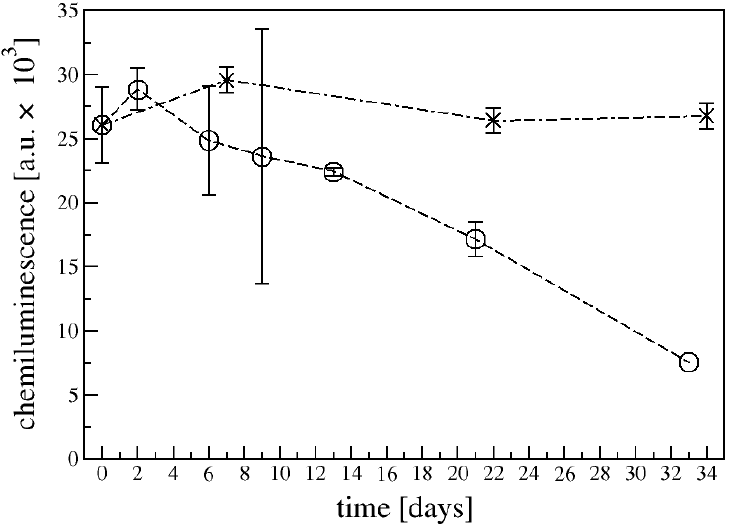
Figure 5. Apt-THR layer aged in PBS solution at 4 ◦ C (circles) [4] or − 20 ◦ C (stars). Data are reported as mean value of two samples. Error bars represent the standard deviation. Exposition time: 0.5 s .